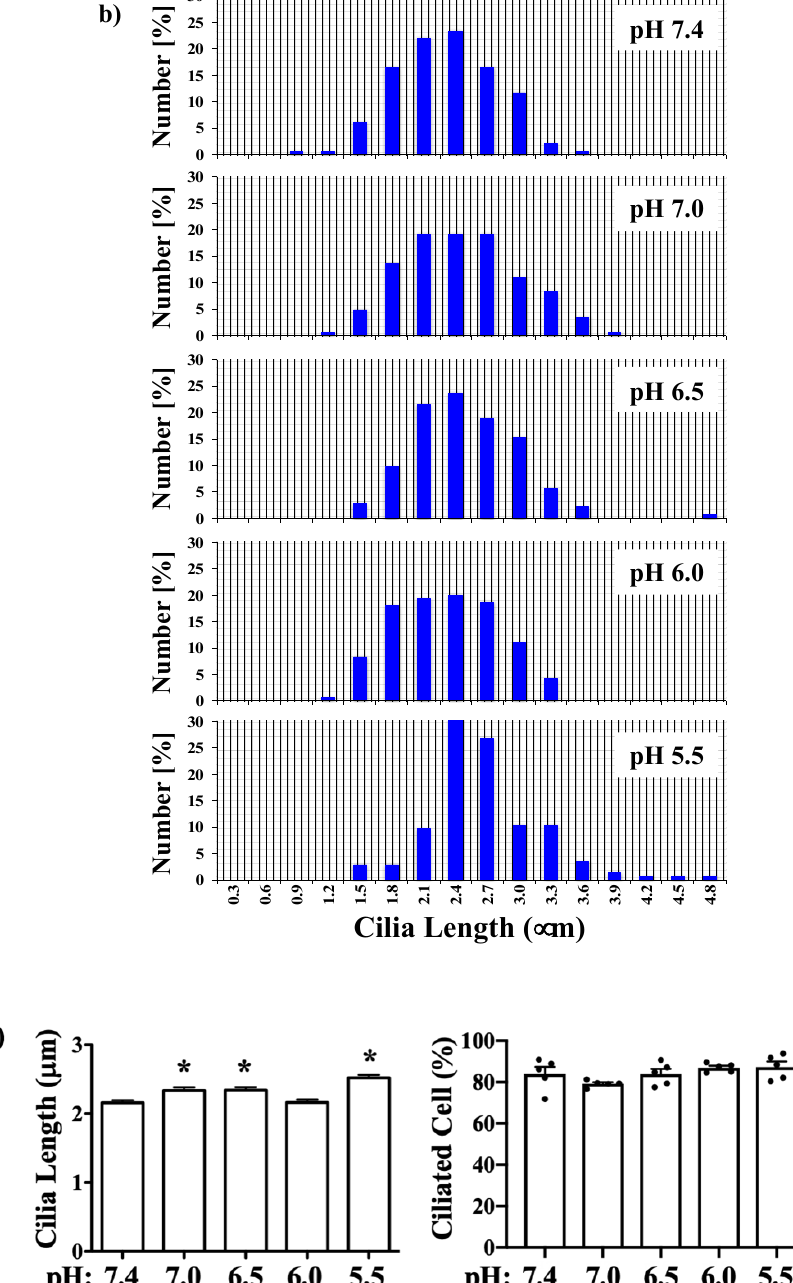
Figure 2. Immunofluorescence staining to study e ff ects of pH o on primary cilia. ( a ) Cells (wild-type and Tg737 ) were stained with ciliary marker (acetylated- α -tubulin; green) and nucleus marker (DAPI; blue). Representative images are shown for wild-type cells at di ff erent pH o and Tg737 at pH o 7.4. White boxes show enlargement of the images to depict the presence of primary cilia. ( b ) The lengths of primary cilia from 50 cells were measured from each preparation (N = 3) and illustrated in the bar graph to depict length distribution within each pH o . ( c ) Cilia length was averaged from 150 cells (N = 3; each with 50 randomly selected cells) and the number of cells possessing cilia represented as a percentage with each point representing an individual experimental datapoint. * indicates a significant di ff erence to control pH o 7.4.